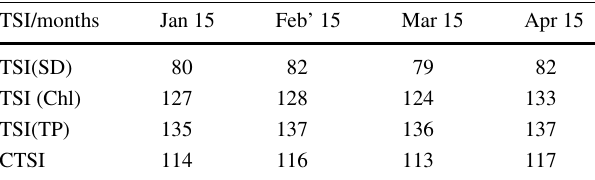
Table 2 TSI values for SD, TP, Chl(a) in pond during the